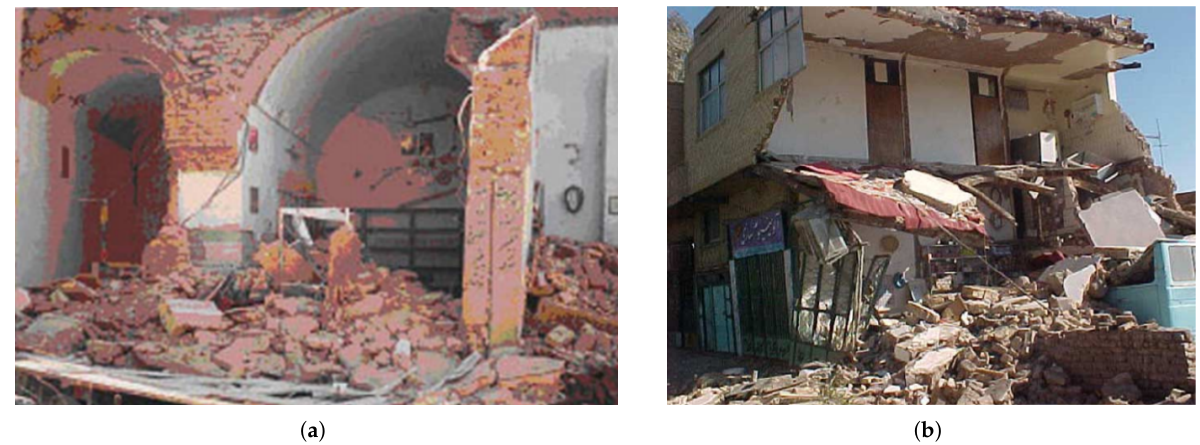
Figure 4. ( a ) Partially damaged old masonry buildings’ arch roofs in Bam after the earthquake [31]; ( b ) the inconsistency of the multi-arched roof with the supports due to the lack of horizontal coils, as well as the high thickness and weight of the roof [31].